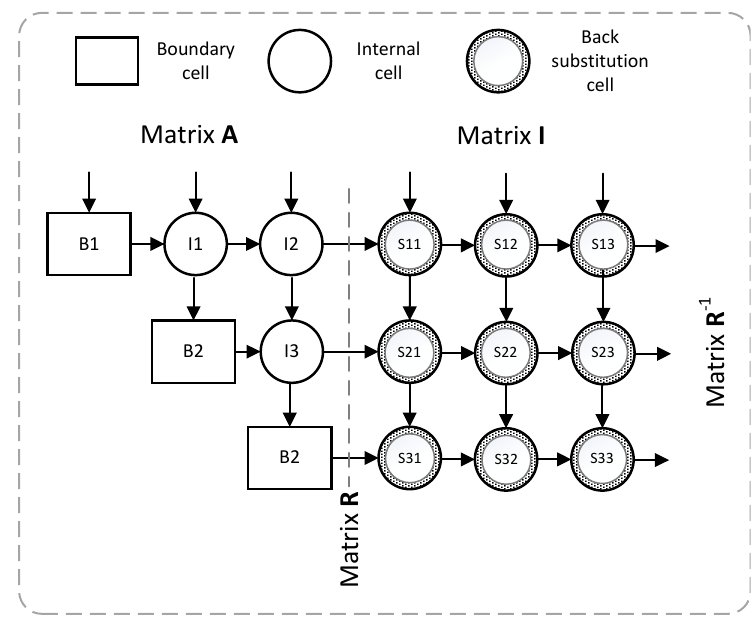
Figure 2. Two-dimensional systolic array architecture for QR decomposition and back-substitution